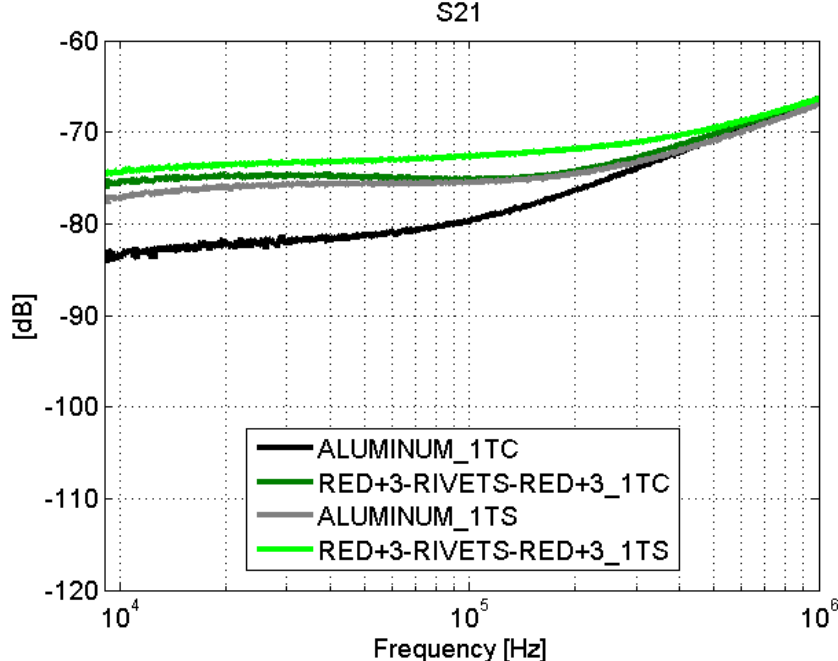
Figure 18. Surface current test: S 21 . red+3–rivets–red+3 and aluminum. Line 1T.